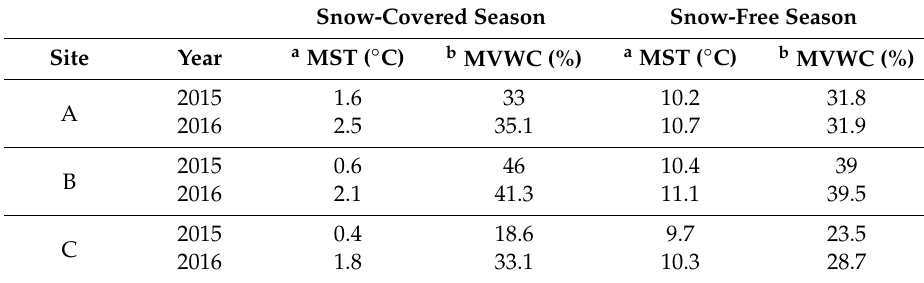
Table 2. Mean soil temperature (MST) and volumetric water content (VWC) over the two years in the 3 study sites.